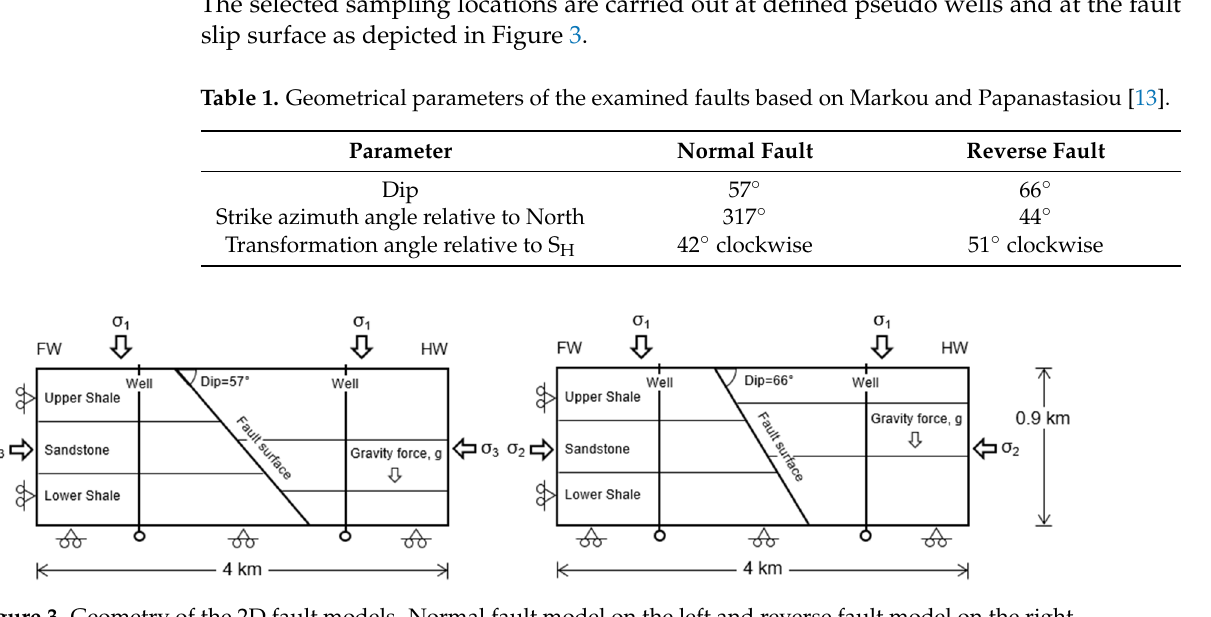
Table 1. Geometrical parameters of the examined faults based on Markou and Papanastasiou [13].